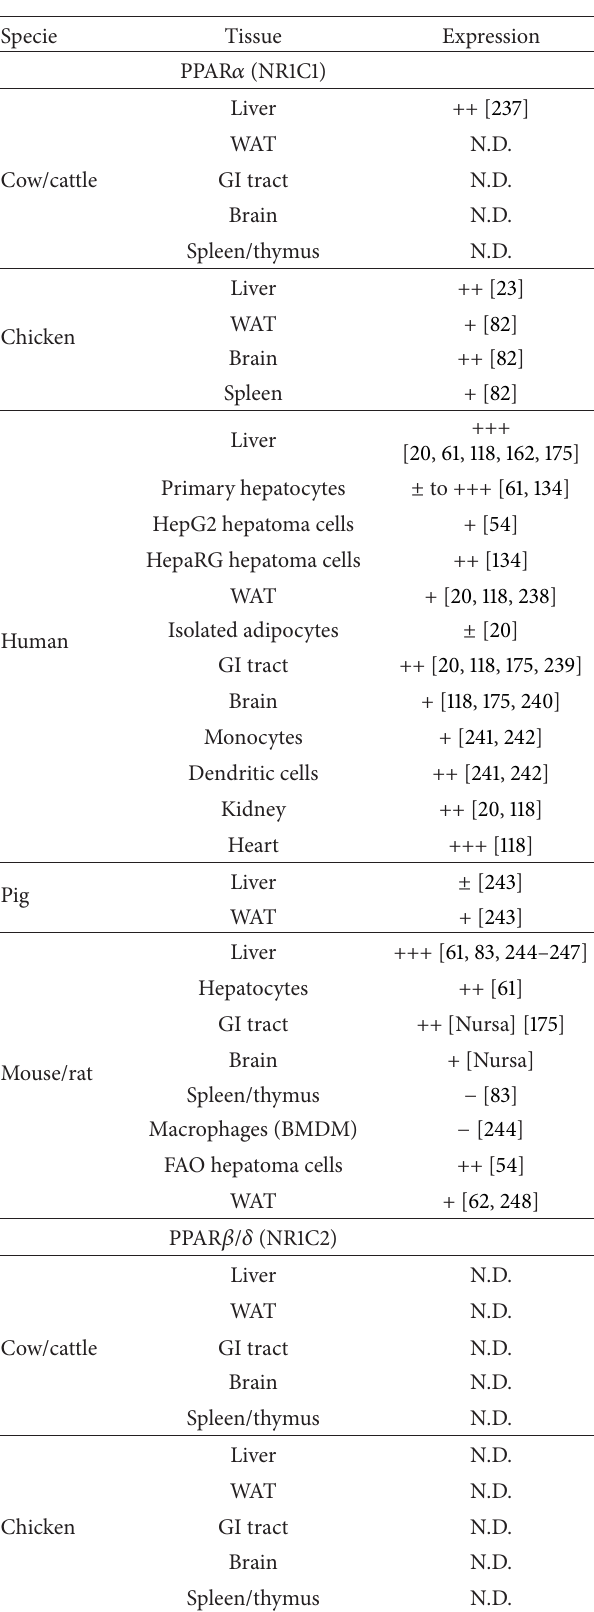
Table 1: Tissue distribution of the various PPARs in different